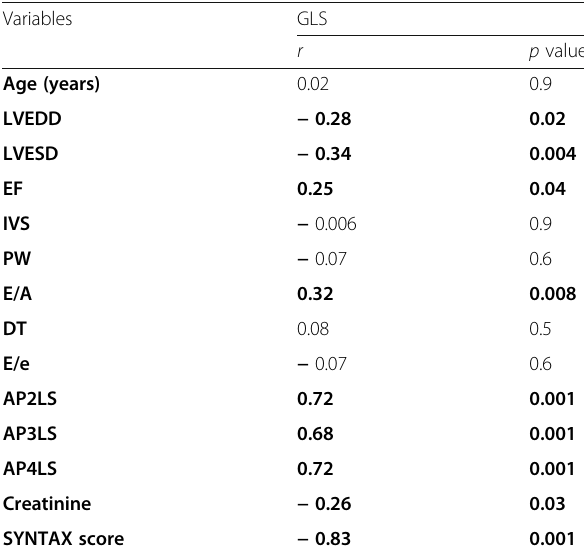
Table 2 Correlation between SYNTAX score and GLS with all study variables among study